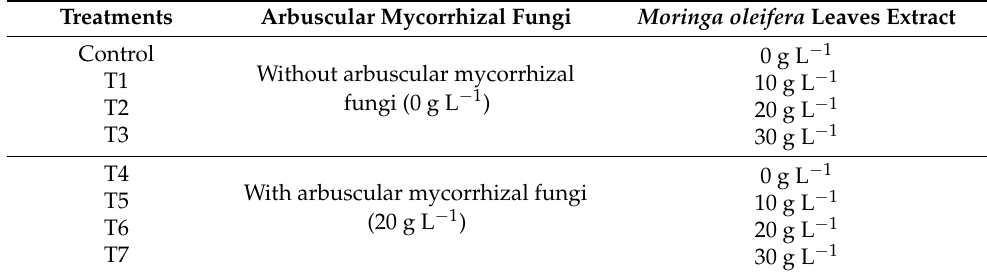
Table 4. The combination treatments of arbuscular mycorrhizal fungi and aqueous extract